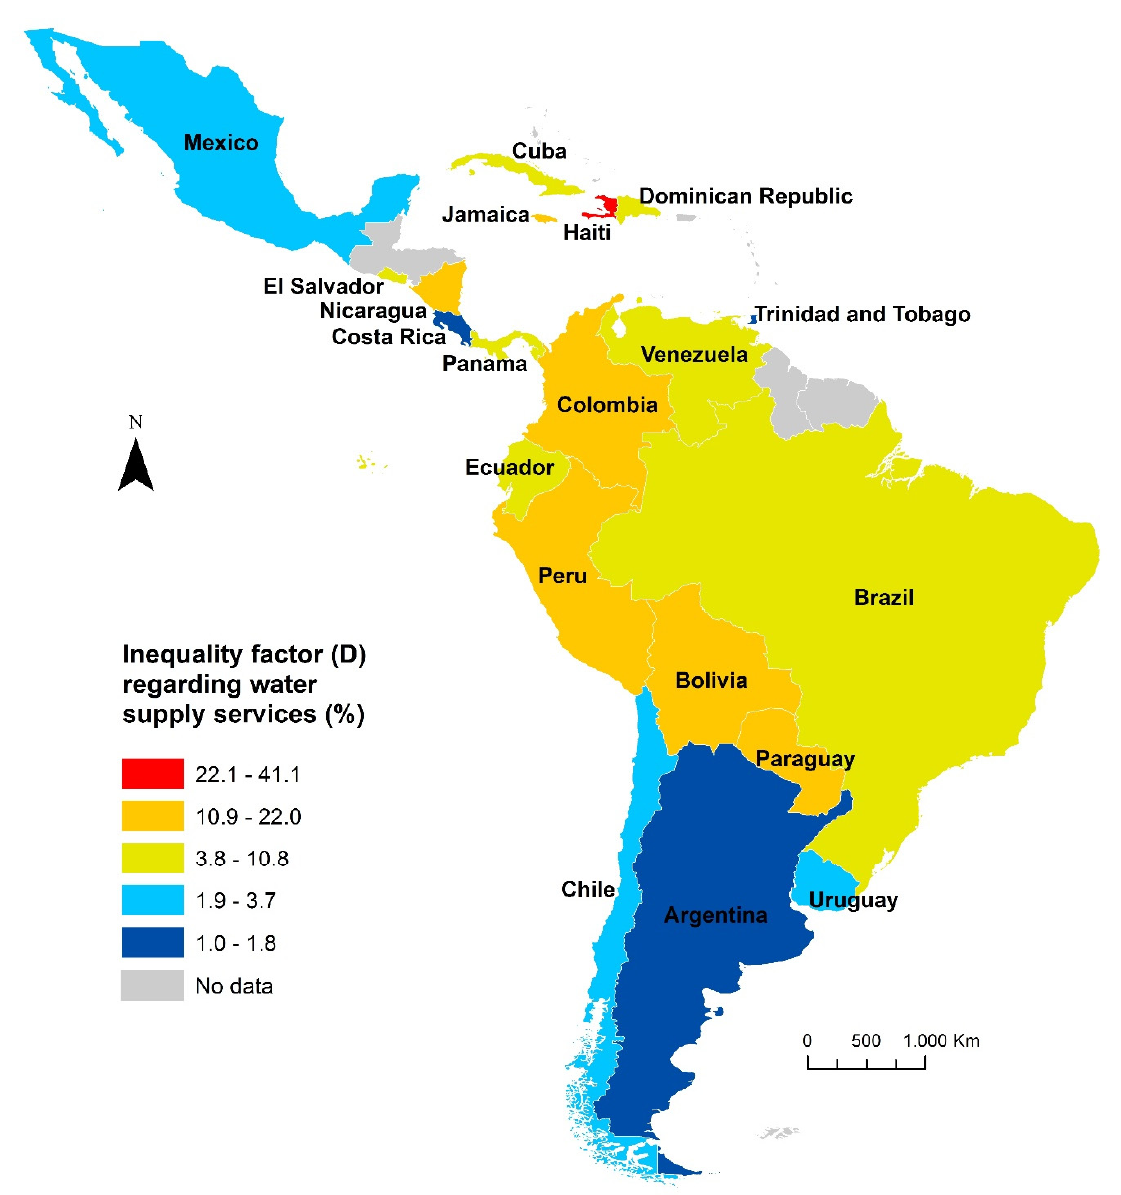
Figure 1. Inequality factor for water supply services. (Note: For better visualization of the values, D is expressed in the map as a percentage. 0% equals perfect equality in access to services, and 100% means maximum inequality). Source: Own elaboration based on census microdata from the IPUMS-International Project